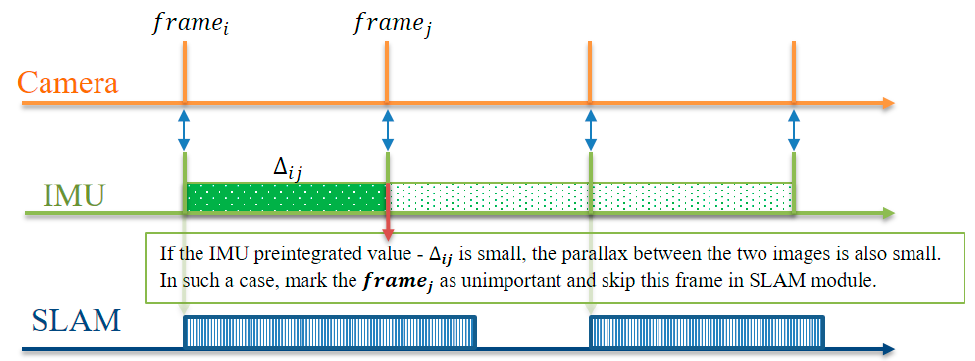
Figure 4. Fusion model of IMU preintegration and the SLAM module. The IMU preintegration value is used to determine the importance of the frame in the SLAM module.